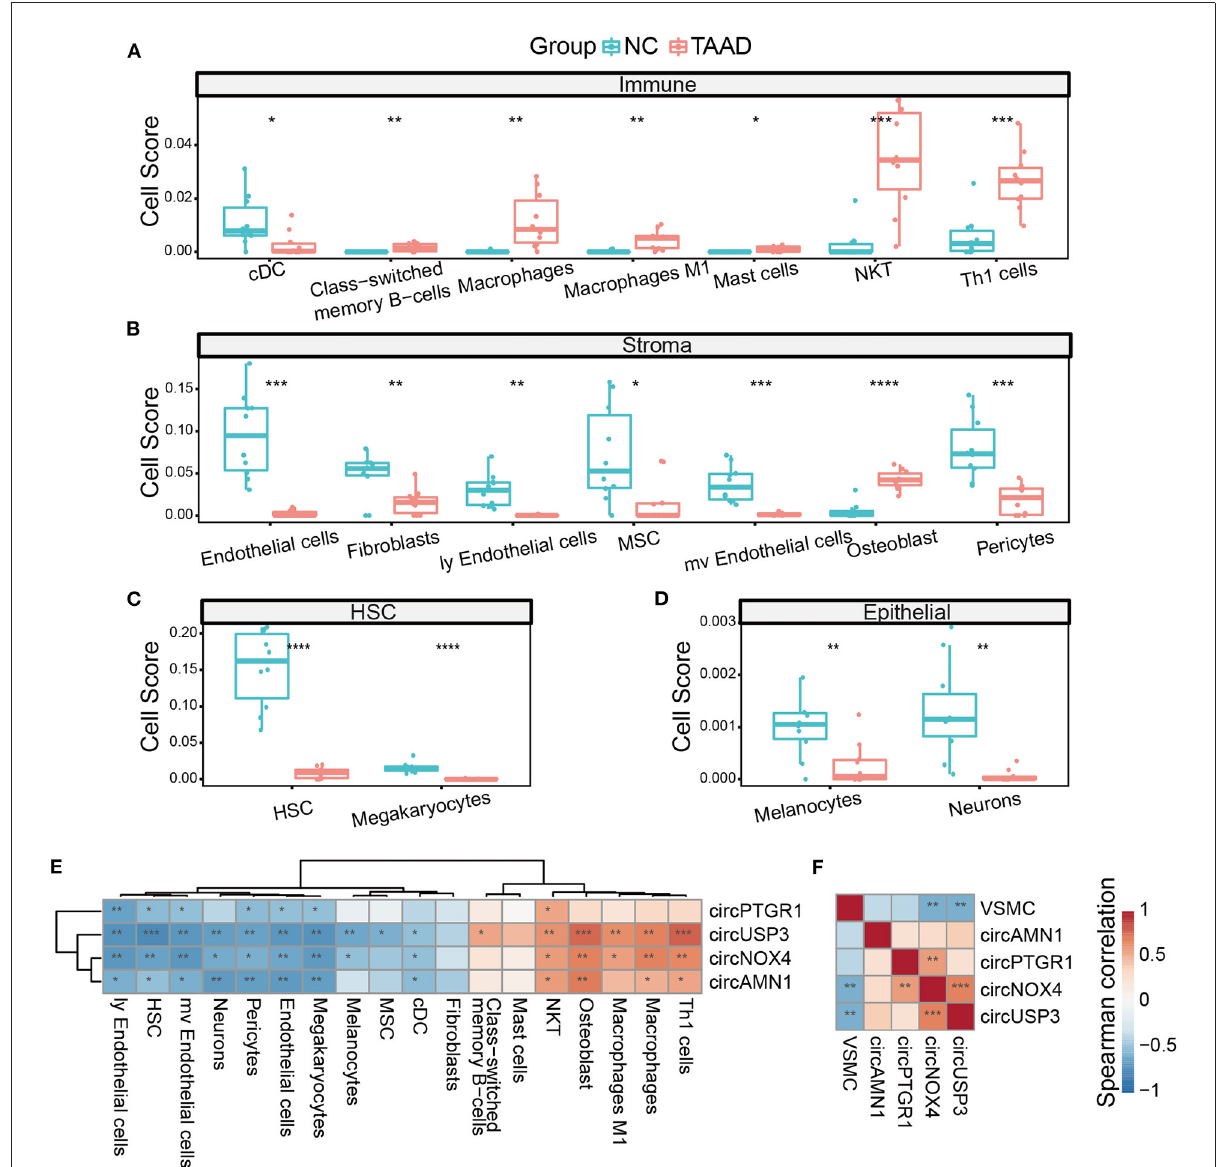
FIGURE5 The circRNAs were correlated with the cell composition of TAAD. (A–D) Different cells, including immune cells (A) , stromal cells (B) , HSC (C) , and epithelial cells (D) , of TAAD aortic tissue and healthy control. (E) Heatmap of Spearman’s correlation of circRNAs expression and different cell scores. (F) Heatmap of Spearman’s correlation of circRNAs expression and VSMC score. * p < 0.05, ** p < 0.01, *** p < 0.001, **** p < 0.0001 (Student’s t -test and Spearman’s